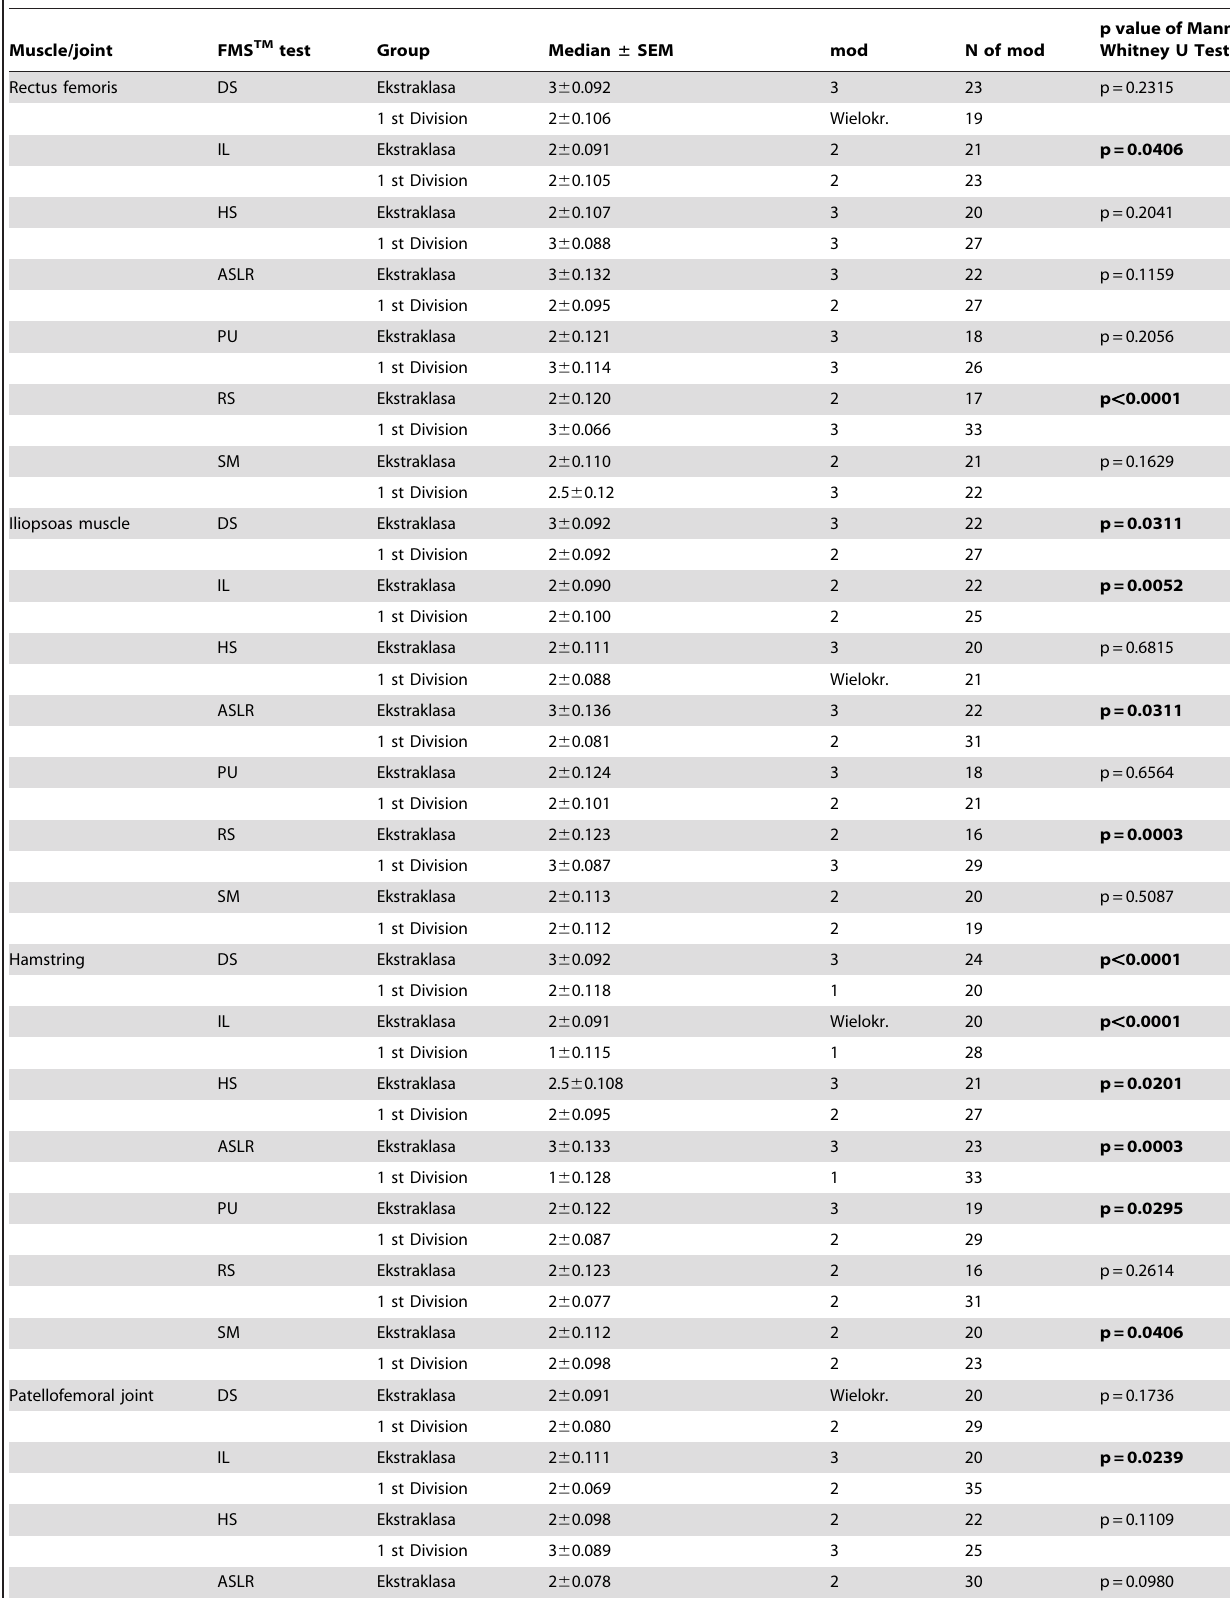
Table 6. Group differences between muscle flexibility and FMS TM test results.